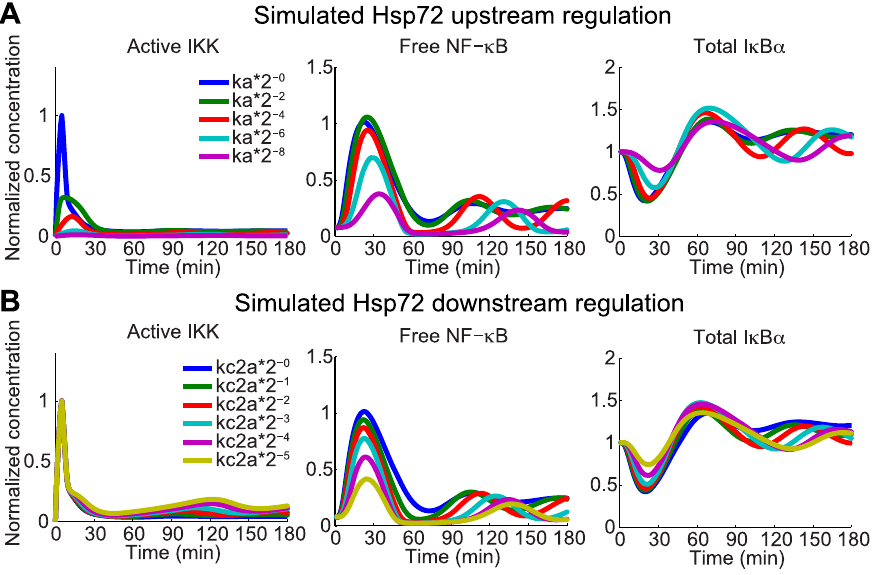
Figure 3. Modeling suggests Hsp72 attenuation of IKK is essential for differential IKK and NF- k B activation. A. Model simulations show expected dynamics of IKK, NF- k B and total I k B a protein when Hsp72 inhibits TNF-induced IKK activation. Each curve corresponds to simulations with rate ka multiplied by the factor indicated. B. Model simulations when Hsp72 is assumed to inhibit phosphorylation of I k B a (rate kc2a ). When phosphorylation is sufficiently attenuated, peak NF- k B activation drops similar to levels observed experimentally, but IKK activation at early times is largely unaffected.